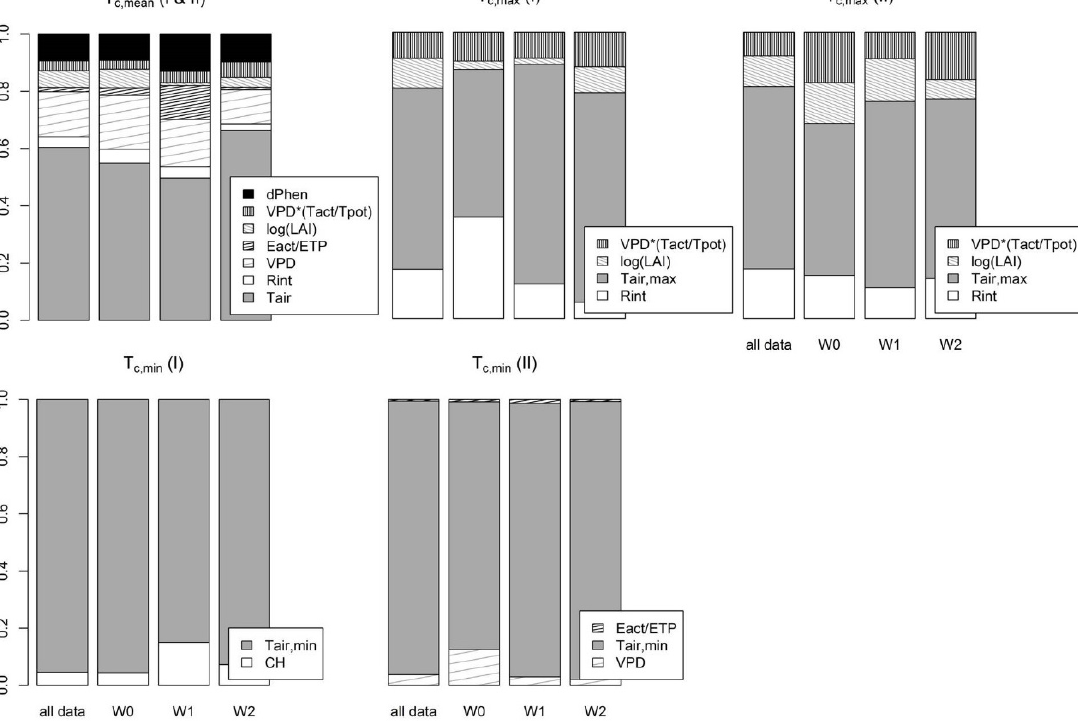
Figure 6. Estimated relative importance of covariates for simulating T c,mean , T c,max and T c,min for the training data set during the pre ‐ heading (I) and the post ‐ heading phase (II). Abbreviations as